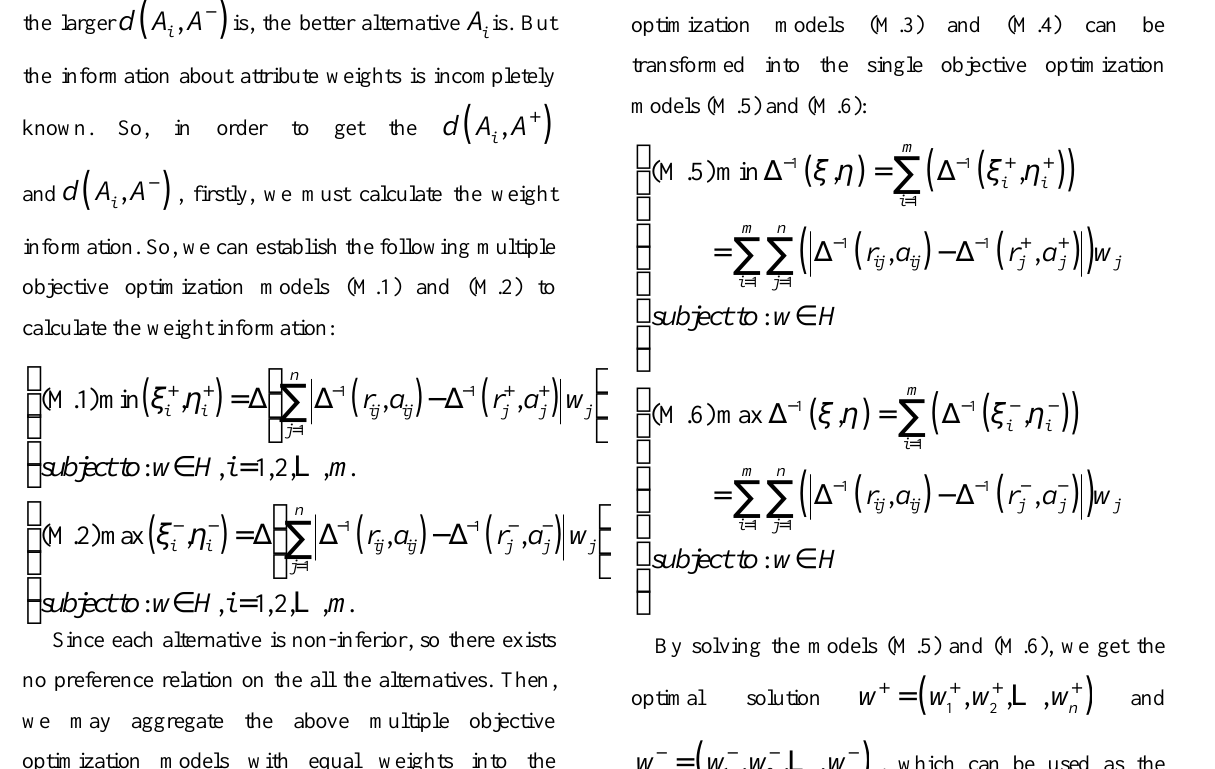
function, multiple objective